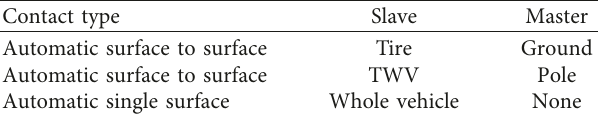
Table 3: Contact between different parts of TWV.